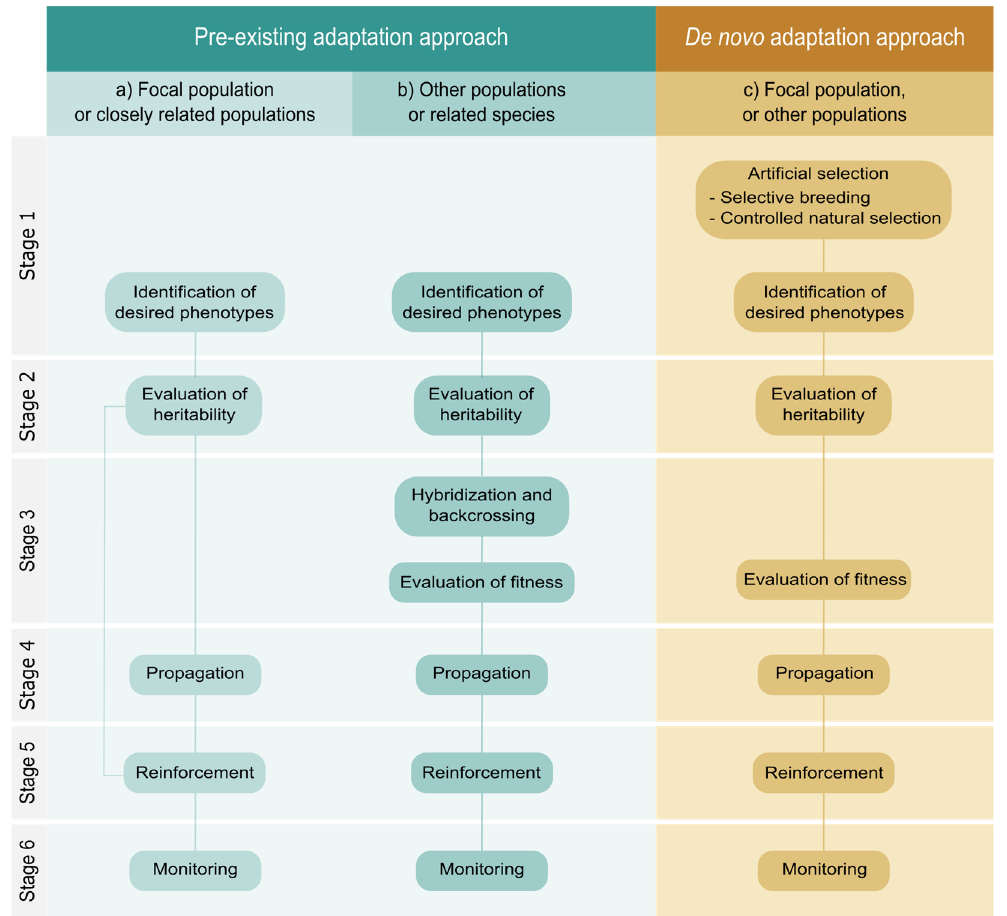
Figure 2. Framework for the implementation of the facilitated adaptation strategy, with alternative procedures depending on the pre-existing genetic variation. ( a ) Pre-adapted individuals from the same population or from other genetically close populations are multiplied and translocated to the focal population. ( b ) Pre-adapted individuals from genetically distinct populations or from related species are crossed with individuals from the focal population. Resulting offspring is repeatedly backcrossed with individuals from the focal population to eliminate undesirable traits while re- taining the targeted trait. Next, the progeny is multiplied and translocated to the focal population. ( c ) Individuals from the focal population or from other populations are selected and crossed repeat- edly to obtain individuals with the desired traits. New allelic combinations could also be promoted by submitting individuals to stress conditions for several generations. Once fitness has been evaluated, pre-adapted individuals are multiplied and translocated. All procedures require a final stage of demographic